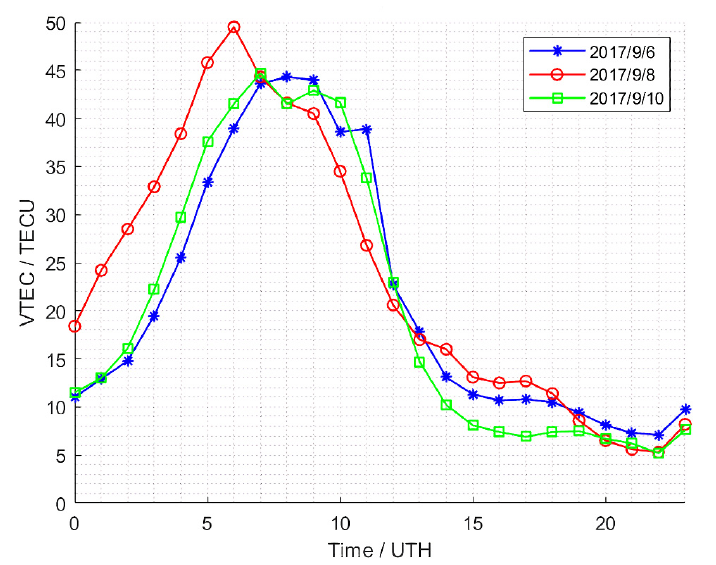
Figure 3. VTEC time series of grid point 1 (22.5° N–110° E). The blue, red, and green polylines represent the fluctuation trend of VTEC before the geomagnetic storm (6 September), during the geomagnetic storm (8 September), and after the geomagnetic storm (10 September), respectively (unit: TECU, 1TECU is equal to 10 16 electron per square meter).